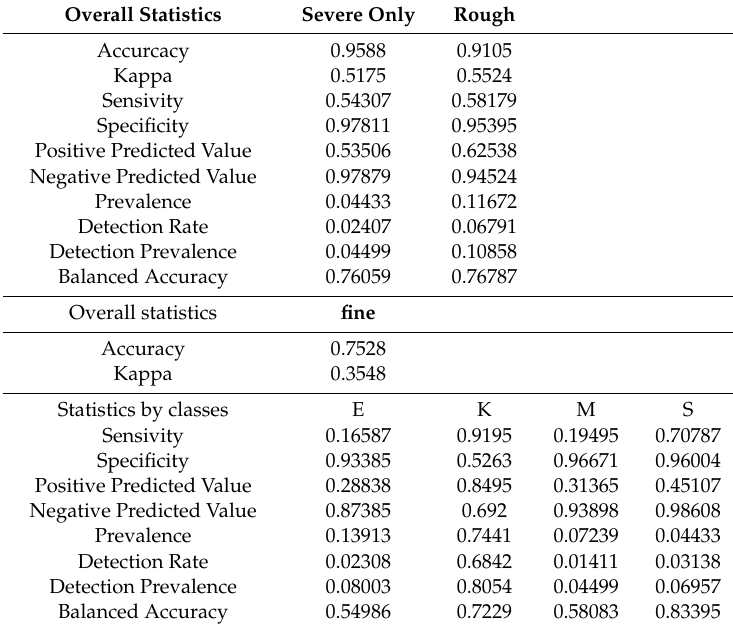
Table 9. Diagnostic values of the random forest classification (prediction) of the cells in this study, grouped into the three categories “severe only”, “rough”, and